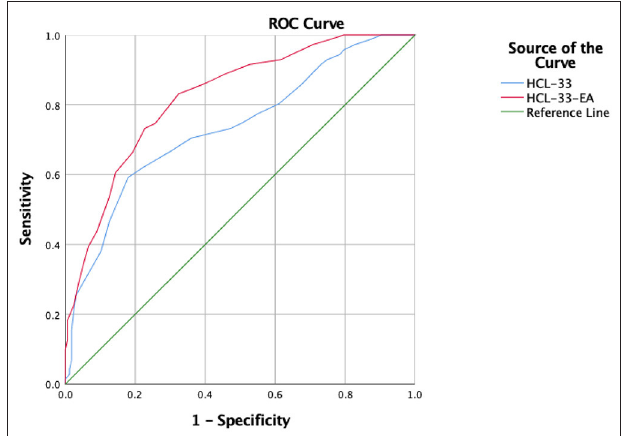
FIGURE 1 | ROC curves for the HCL-33 and the HCL-33-EA. HCL-33, Hypomania Checklist-33; HCL-33-EA, Hypomania